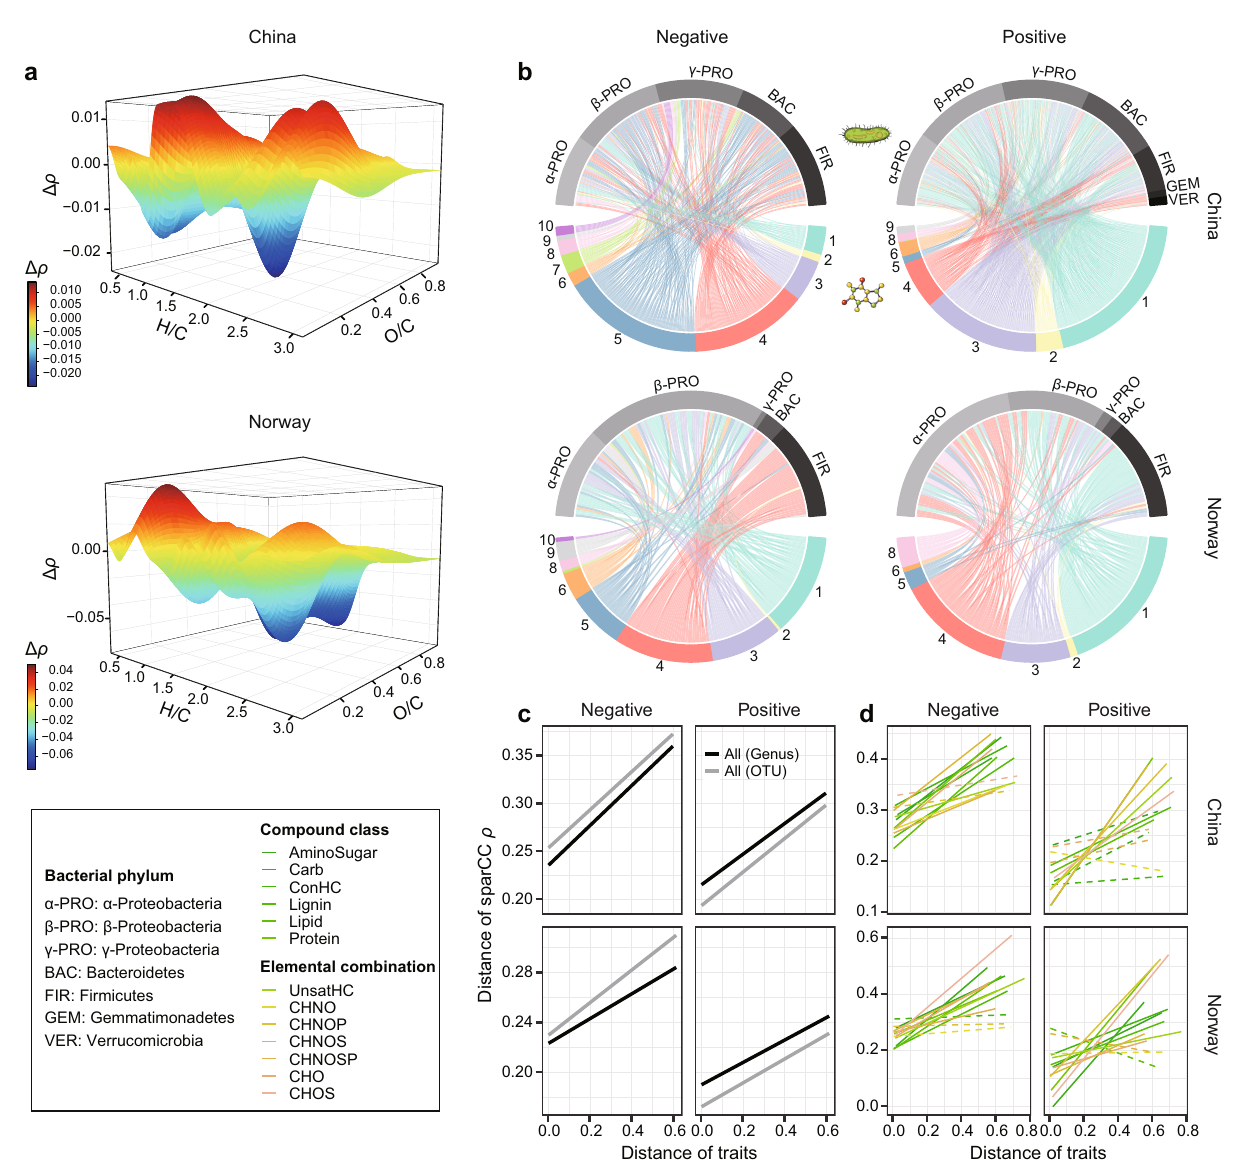
Fig. 4 Ecological networks between DOM and bacteria. a Strength of the correlations between DOM molecules and bacterial OTUs in China (upper panel) and Norway (lower panel). For each molecule across the 150 samples in each region, we subtracted the mean absolute Spearman ’ s rank correlation coef fi cient ρ of all the negative correlations with individual bacterial OTUs from the mean of the positive correlations to derive Δ ρ . Δ ρ was further visualised against the molecular traits H/C and O/C. b The negative (left panel) and positive (right panel) bipartite networks between DOM molecules and bacterial genera in China (upper panel) or Norway (lower panel) estimated using SparCC (Sparse Correlations for Compositional data) 35 . Upper nodes represent bacterial genera coloured by their phylum, while lower nodes represent DOM molecules coloured by the ten clusters obtained with hierarchical cluster analysis based on 16 molecular traits described in Fig. S12a and Table S1. The traits of H/C and O/C for molecules in each cluster are shown in Fig. S12b. A line connecting two nodes indicates an interaction between a DOM molecule and bacterial genus. The ten clusters are indicated by the numbers below the lower nodes. c , d We examined the relationships between molecular traits and the negative (left panel) or positive (right panel) DOM-bacteria bipartite networks in China (upper panel) or Norway (lower panel). Between all pairs of DOM molecules, we calculated pairwise Gower distances of their molecular traits (that is, distance of traits), or the SparCC ρ of molecules with bacterial OTUs (that is, distance of SparCC ρ ). Statistical signi fi cance between these two distance matrices was determined with a two-sided Mantel test with 999 permutations and indicated by solid ( P ≤ 0.05) or dotted ( P > 0.05) lines. We considered all formulae ( c ) and also subsets of formulae within the category of compound classes or elemental combinations ( d ). For all formulae ( c ), we calculated SparCC correlation coef fi cients based on both bacterial OTUs (grey lines) and genera (black